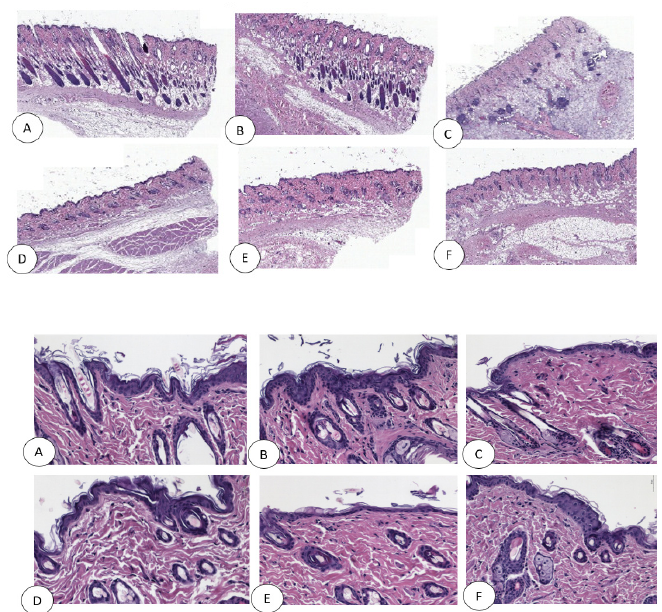
Figure 6. Representative histopathological images of skin sections from oral buccal mucosa of rats in the six experimental groups. ( A ): WT group; ( B ): 100-only group; ( C ): 5-FU group; ( D ): 5-FU+G group; ( E ): 5-FU+50 group; ( F ): 5-FU+100 group. Skin sections were hematoxylin and eosin (H&E) stained. The upper region shows images with 200 times magnification; the lower region shows enlarged images of 5 μ m.